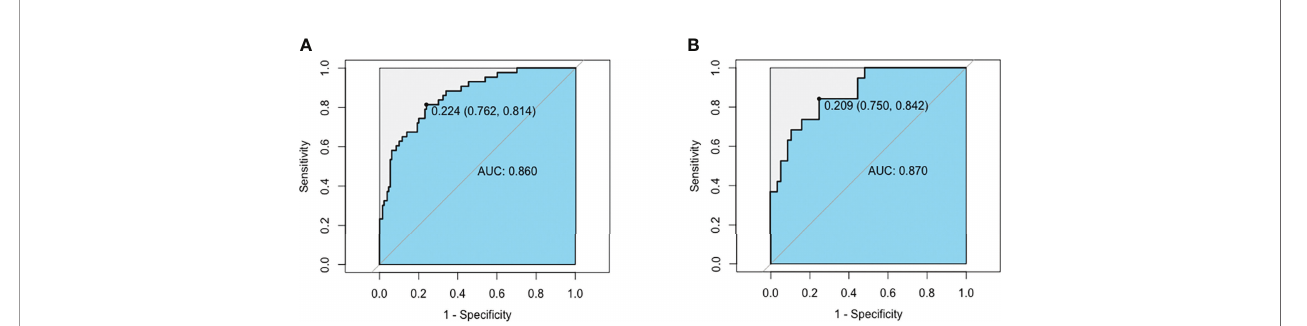
FIGURE 2 | AUC of the MMN risk nomogram model. (A) ROC curve based on potential risk factors showing discrimination rate for MMN and IMN in training group. (B) ROC curve based on potential risk factors showing discrimination rate for MMN and IMN in test